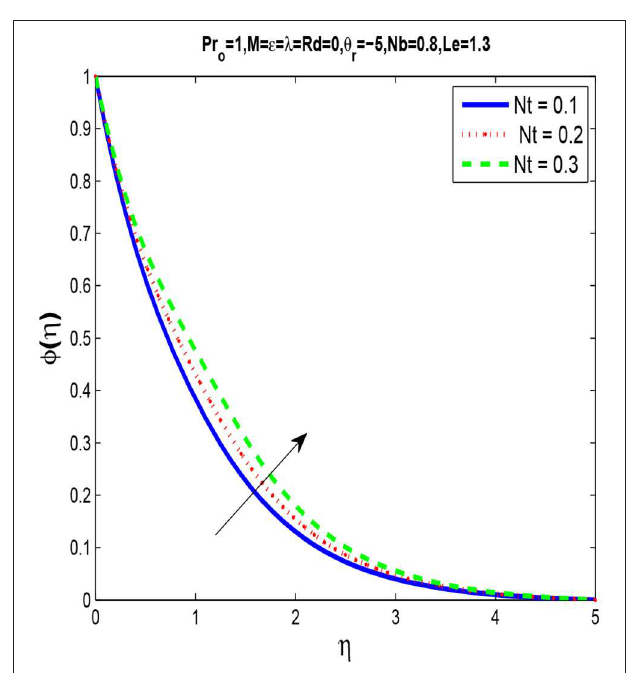
FIGURE 8 | Concentration profile φ ( η ) for different N t ( For Case B).